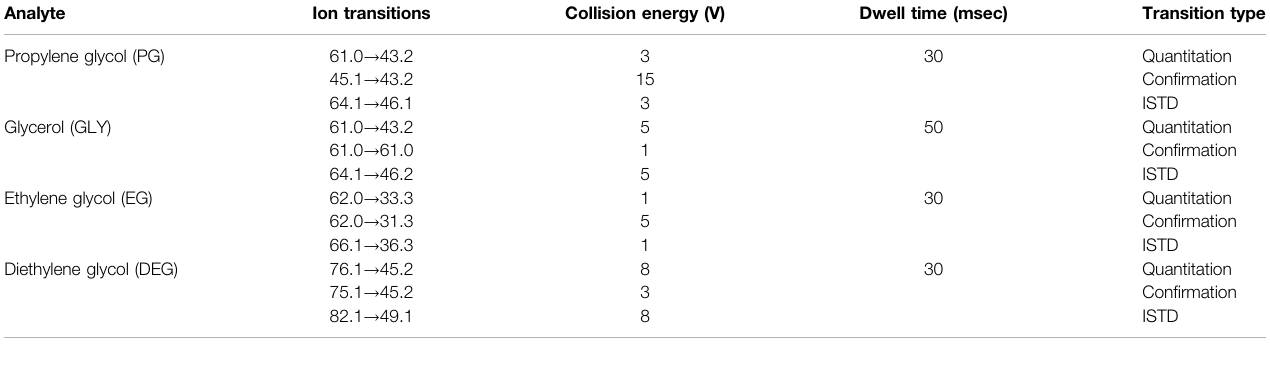
TABLE 1 | SRM method speci fi cations.